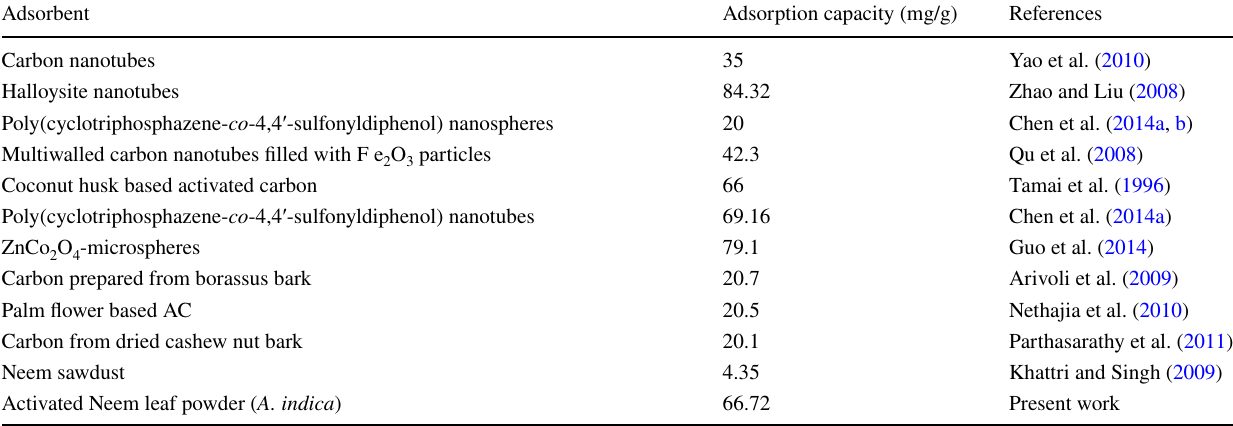
Table 10 Comparison of the maximum adsorption capacity of MG dye by different low-cost biosorbents with the present adsorbent used in